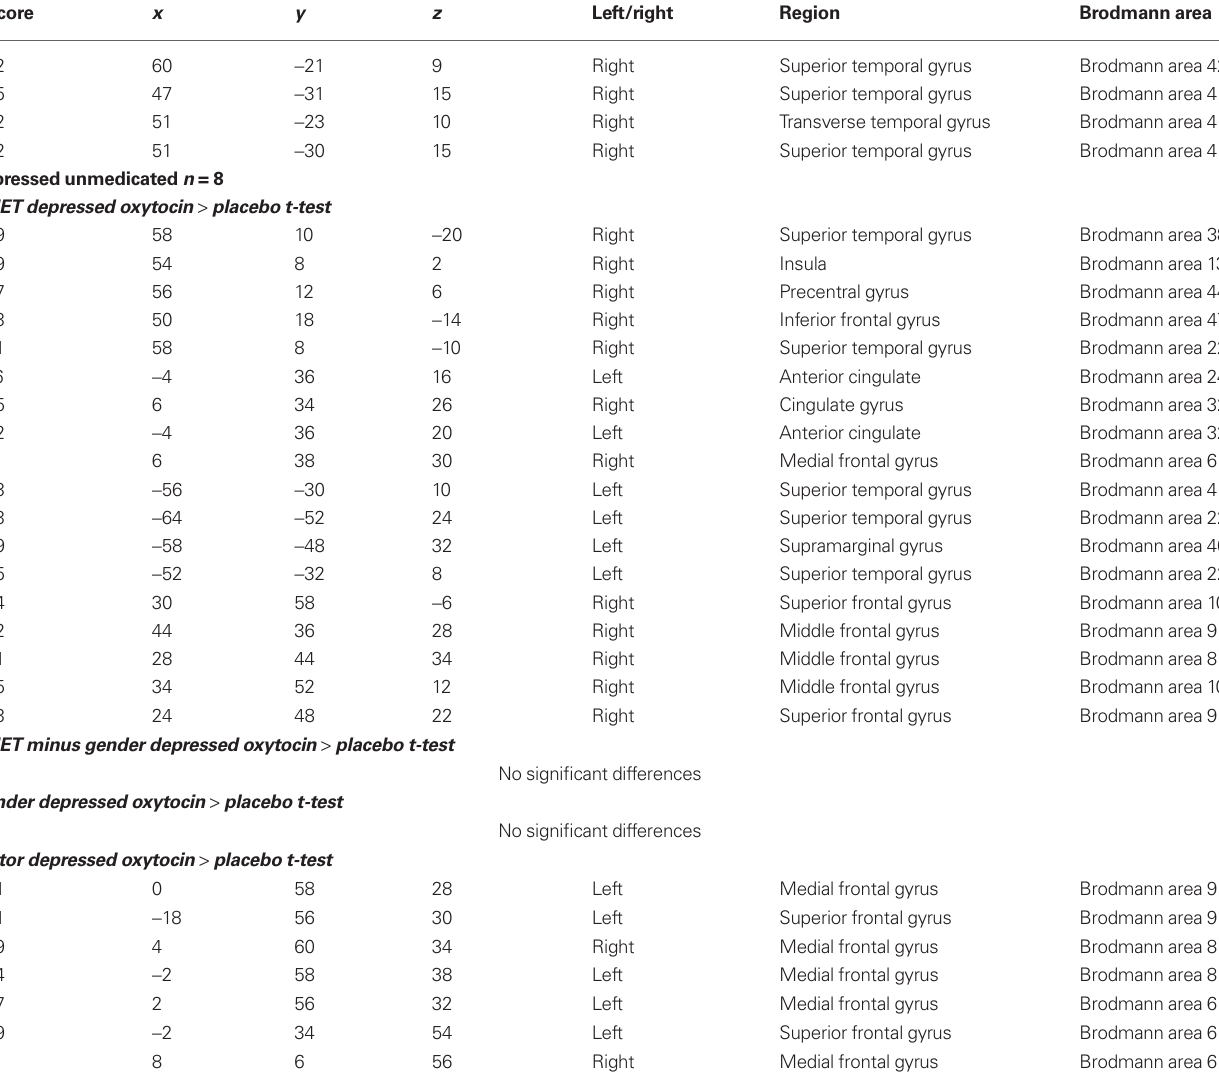
Depressed group. During RMET, there was significant activation with oxytocin compared to placebo in bilateral superior tempo- ral gyrus (BA38, 41, and 22), right insula, right precentral gyrus (BA44), bilateral cingulate gyri (BA32), left anterior cingulum (BA24), left supramarginal gyrus (BA40), right inferior frontal gyrus (BA47), right superior and middle frontal gyri (BA8, 9, and 10) (see Figure 3 ). On motor cues, oxytocin led to significant increases in bilateral superior and medial frontal gyri (BA6, 8 and 9). Gender identifications and RMET minus gender identifications did not differ between oxytocin and placebo